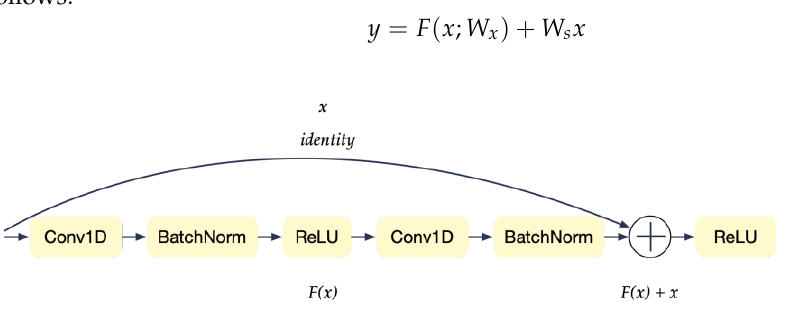
Figure 6. Residual blocks in ResNet-18.